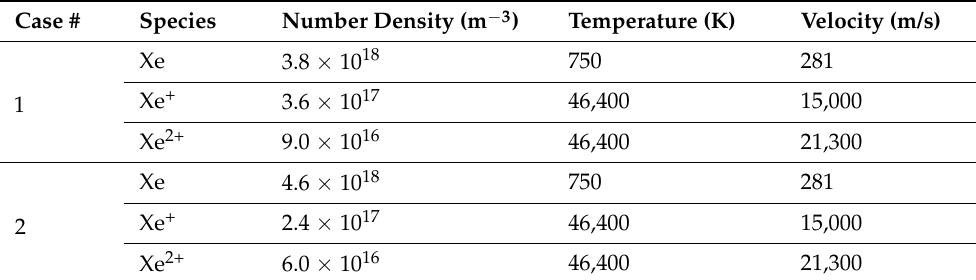
Figure 3. Computational domain and boundary conditions. Table 2. Thruster exit conditions for the numerical simulation in this study.